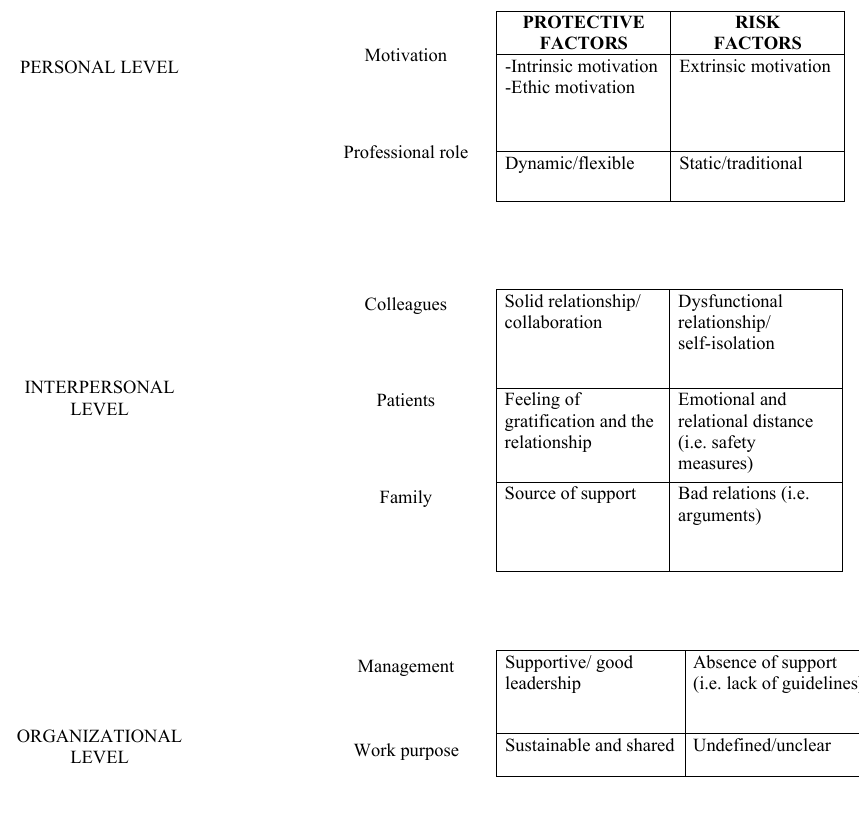
Figure 1. Data Figure 1. Data structure.